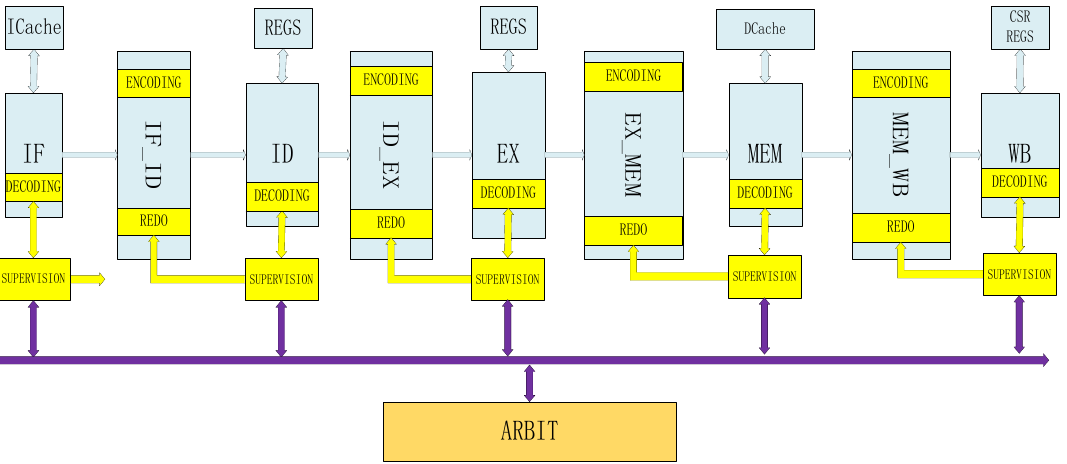
Figure 7. Processor fault-tolerant architecture based on pipeline rollback. REDO: The REDO module is embedded in sequential logic. It records the current